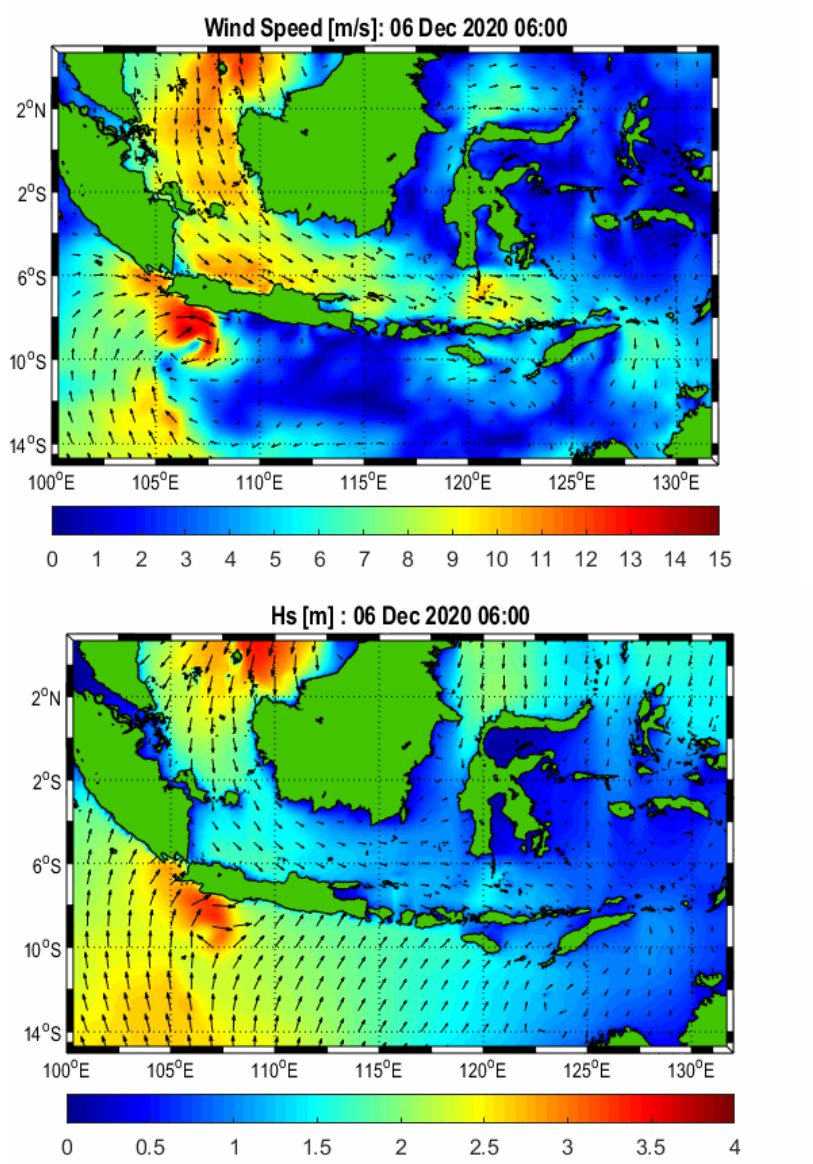
Figure 5. Similar to Figure 4 for Domain-2.